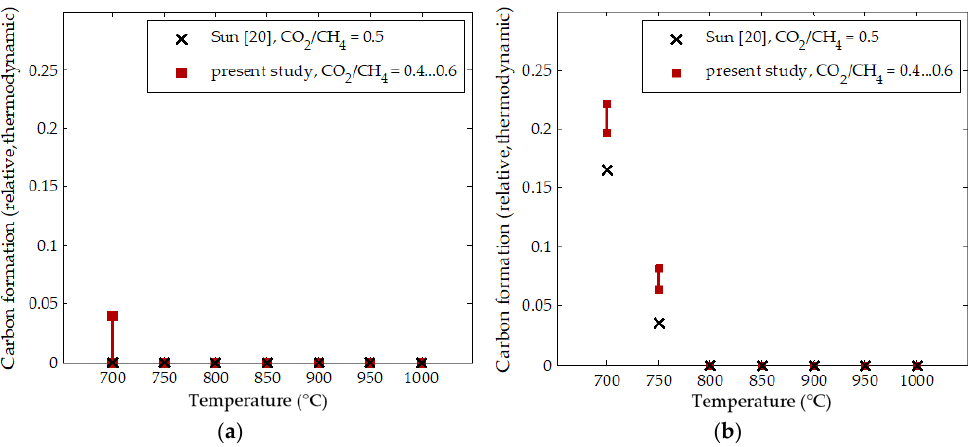
Figure 5. Comparison of carbon formation results with results presented by Sun, et al. [20]. For H 2 O/CH 4 = 1 at 1 bar ( a ) and 5 bar ( b ).